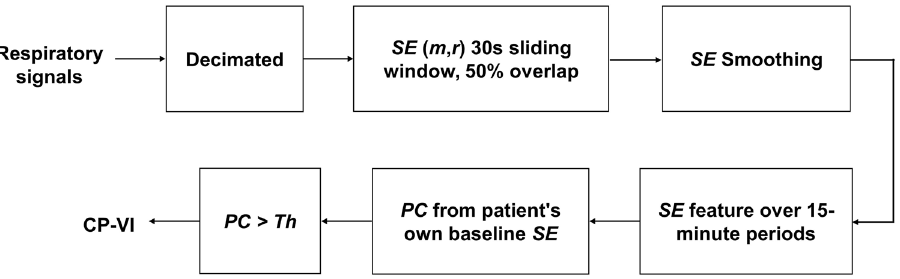
Figure 2. Automatic CP-VI detection. Respiratory signals (Flow and Paw) are decimated at a sampling rate of 40 Hz. Sample entropy ( SE ) is calculated for different values of the embedding dimension ( m ) and tolerance ( r ). An 8-period-long exponential moving average is used to reduce noise and to increase the consistency of the SE results. Two SE features are determined for each 15-min period: the mean value and the maximum value. The percentage of change ( PC ) from the patient’s own baseline value is calculated for each SE setting. When PC exceeds a determined threshold ( Th ), the period is considered to contain a CP-VI event. An optimization procedure is required to select the values of m , r , Th , respiratory signal, and SE feature that yield the most robust estimations of